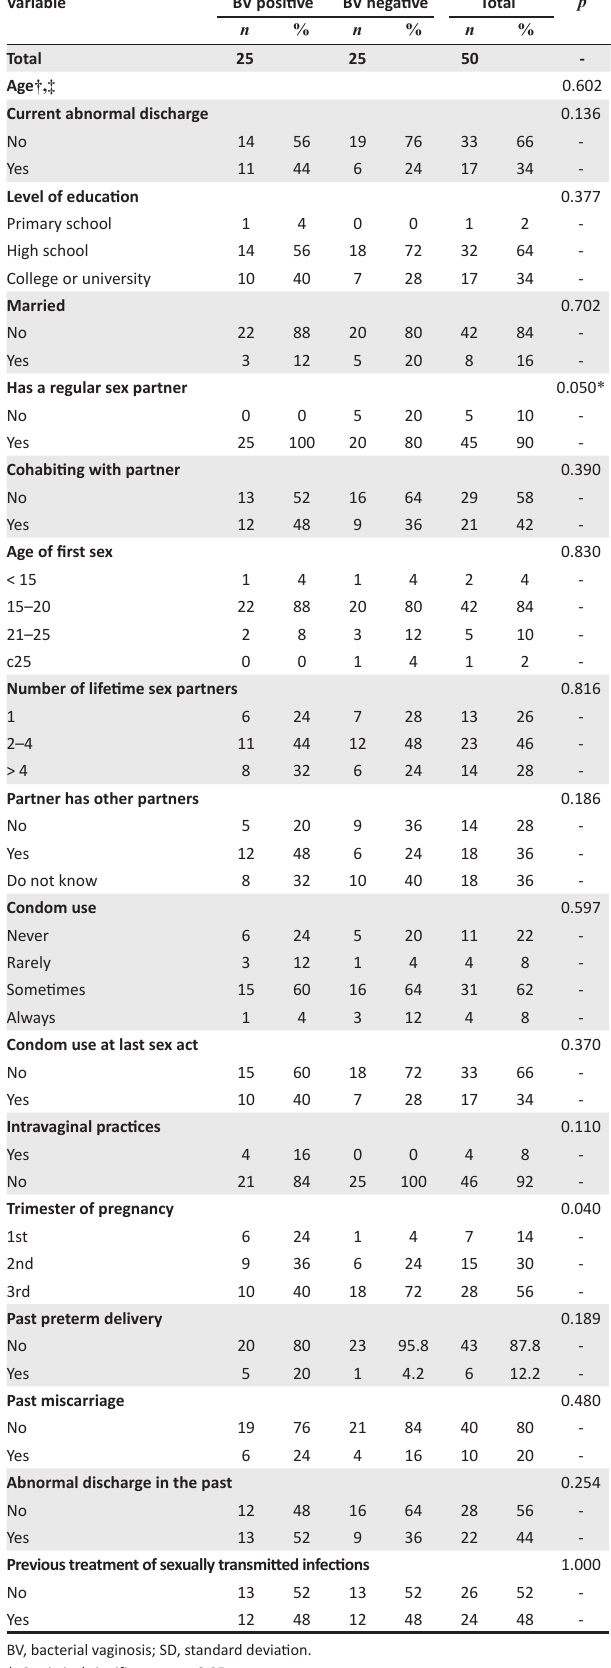
TABLE 1: Characteristics of the women investigated in this